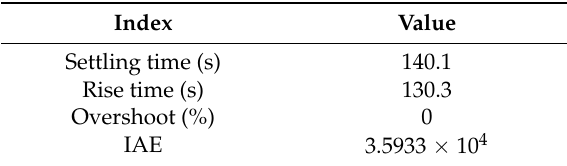
Table 1. H ∞ controller set-point performance